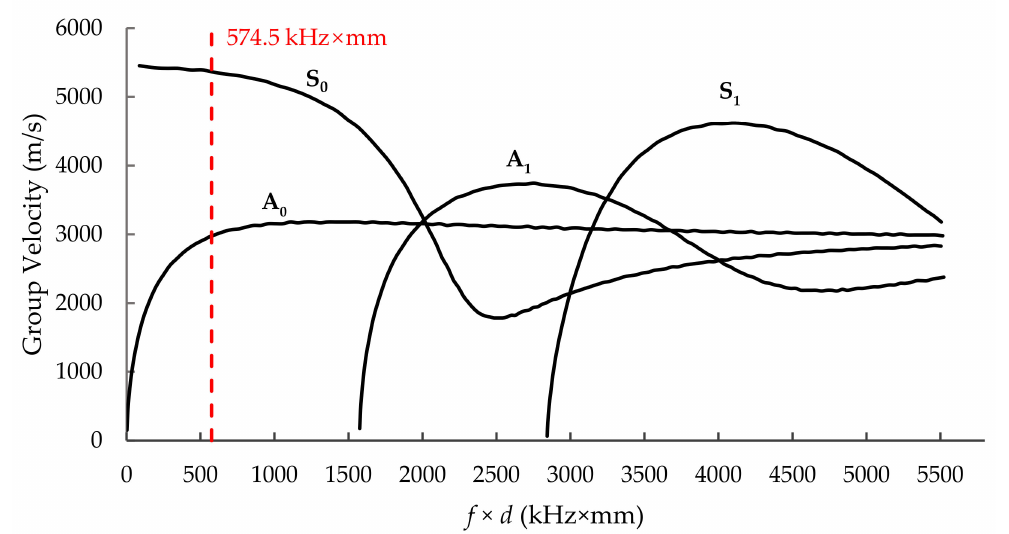
Figure 5. Dispersion curves for Lamb wave propagation in aluminum